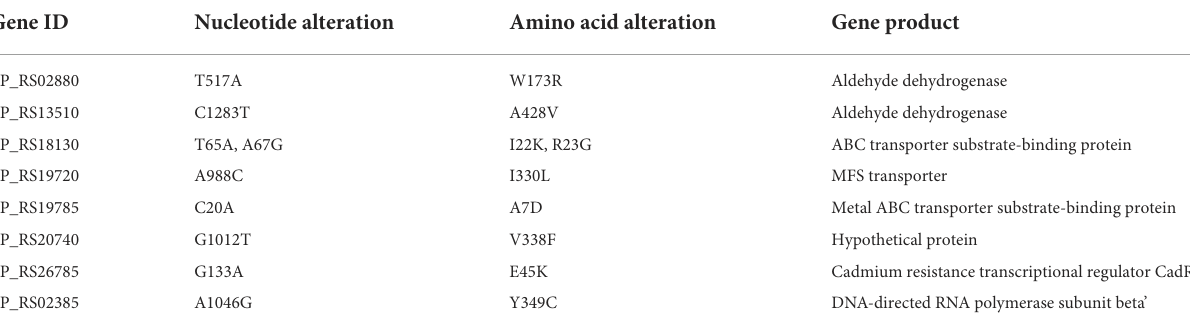
TABLE 1 Non-synonymous mutations of evolved strain identified by genome